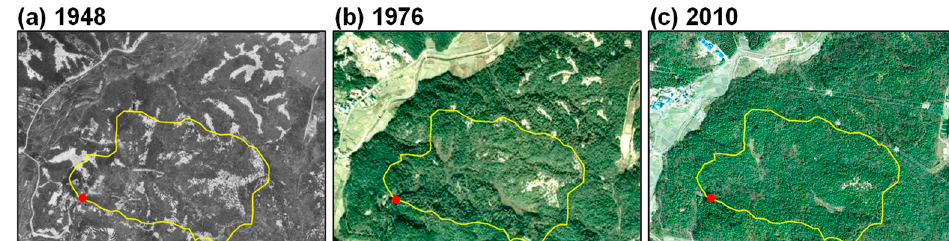
Figure 3. Gradual forest recovery in the Ananomiya experimental forest area. ( a ) White areas are bare and exposed weathered granite subsoil. ( b , c ) show gradual forest recovery—corresponding to the reducing bare (white) areas. The reference point (red dot) is the same as in Figure 2.